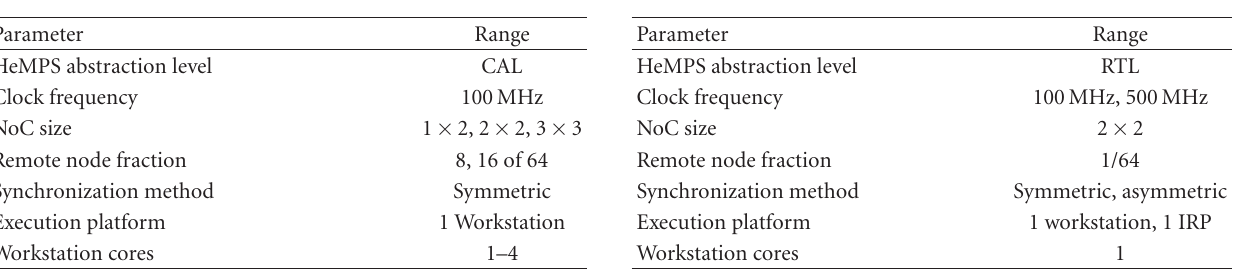
Table 3: Parallelization benchmark configuration. Table 4: Emulation benchmark